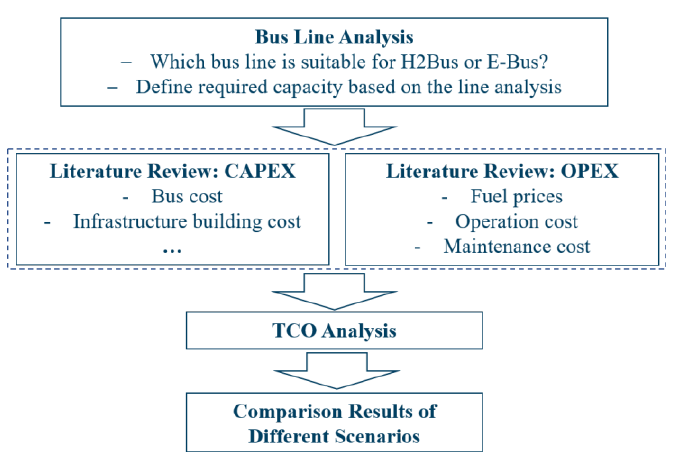
Figure 1. Flowchart of the proposed total cost of ownership model.